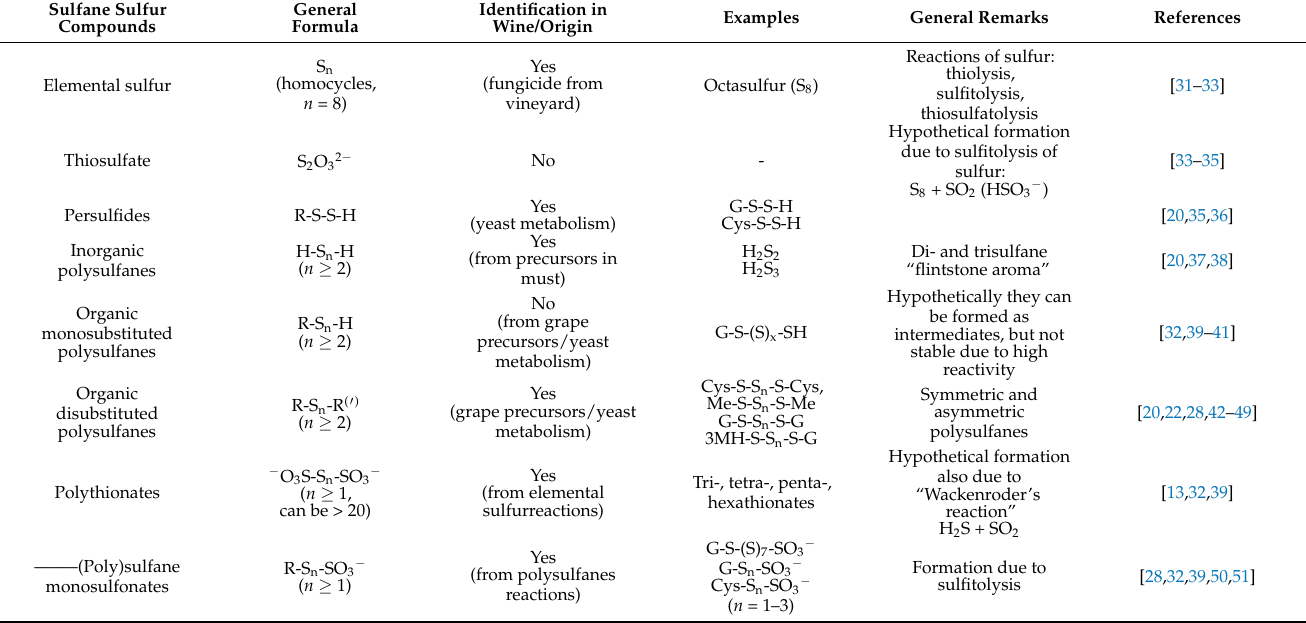
Table 1. Compounds with sulfane sulfur in wine.